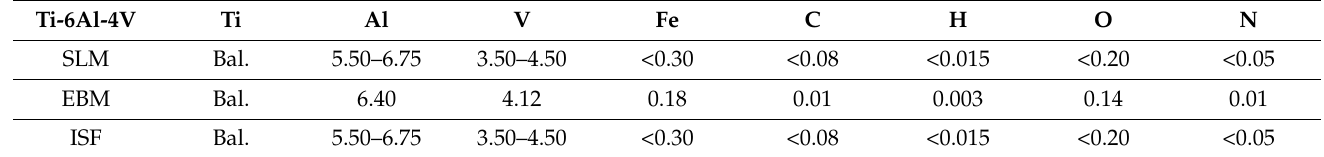
Table 1. Chemical composition (wt.%) of SLM, EBM and ISF Ti-6Al-4V samples.